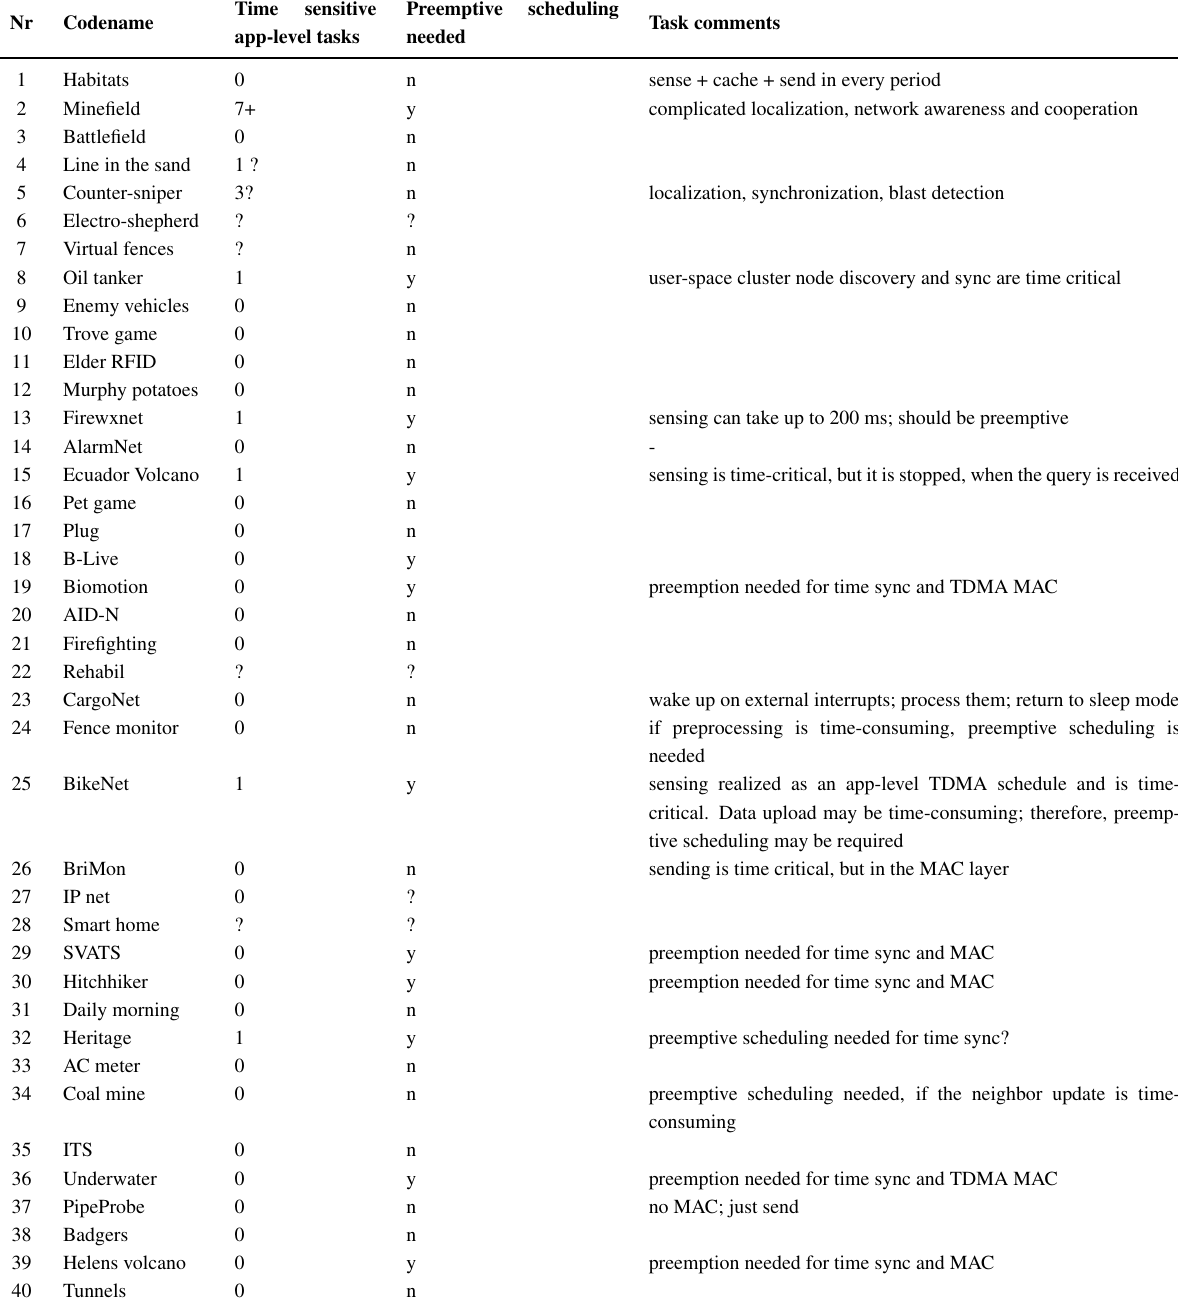
Table 15. Deployments: task